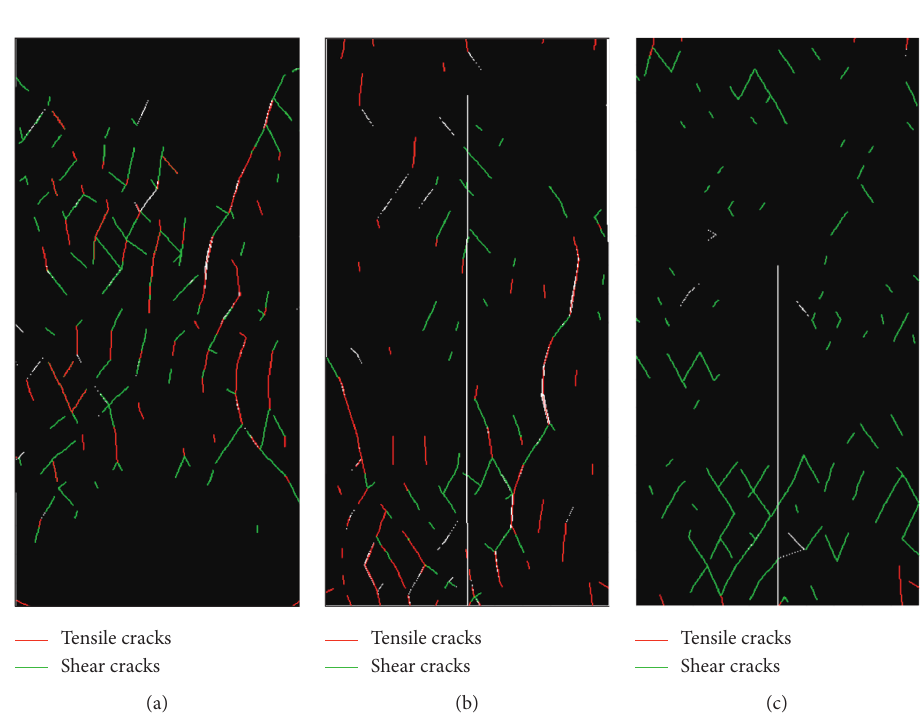
Figure 3: Failure of anchorage body: (a) no rock bolt; (b) a rock bolt with low pretension; (c) a rock bolt with high